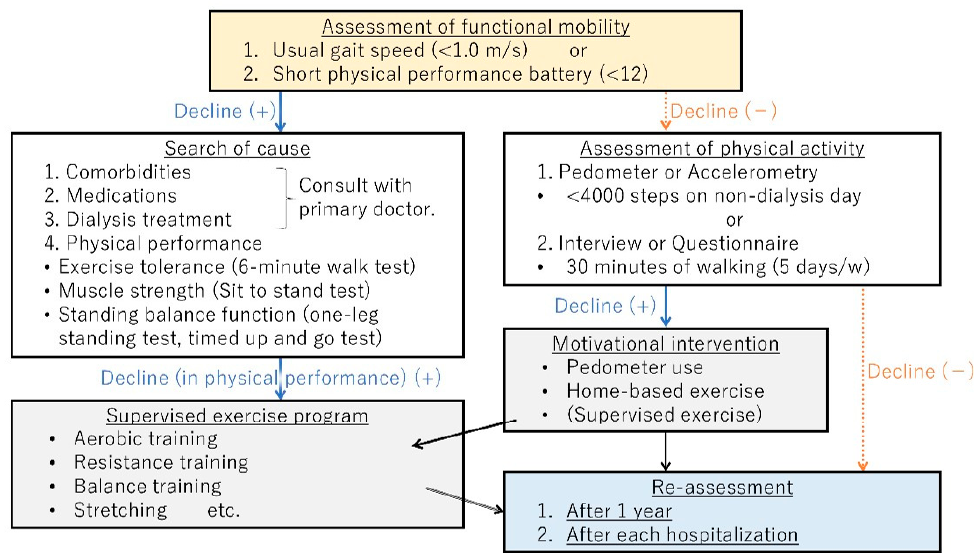
Figure 4. Clinical algorithm for the management of physical frailty in patients on hemodialysis, adapted from Matsuzawa et al.